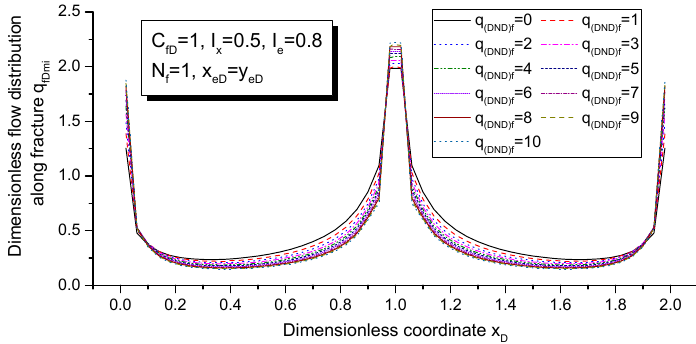
Figure 10. Influx-flow distribution along the fracture under the influence of non-Darcy flow.